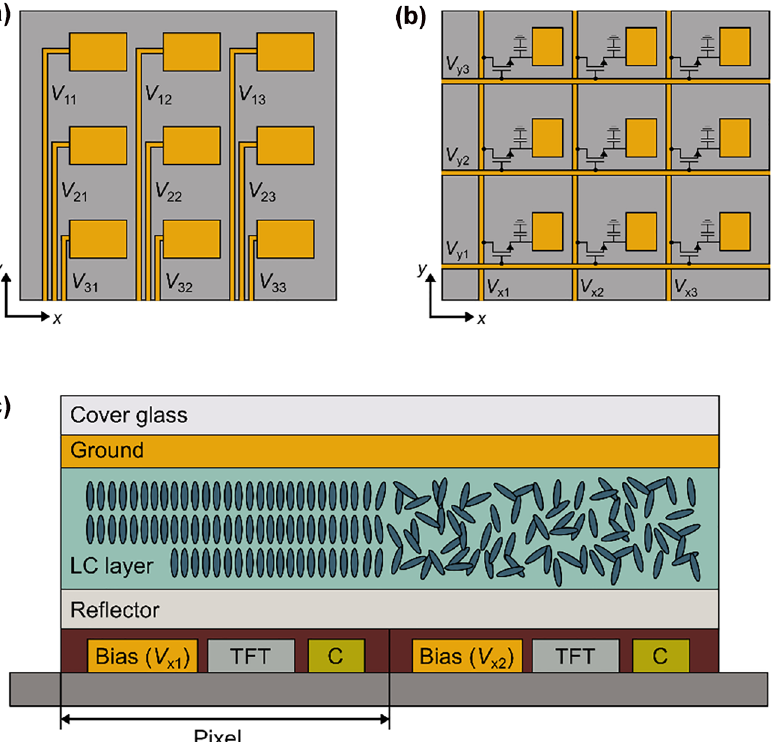
in a m × n array, where m and n are the number of rows and columns, mn and V . A switching transistor and storage capacitor are built in at xn ym